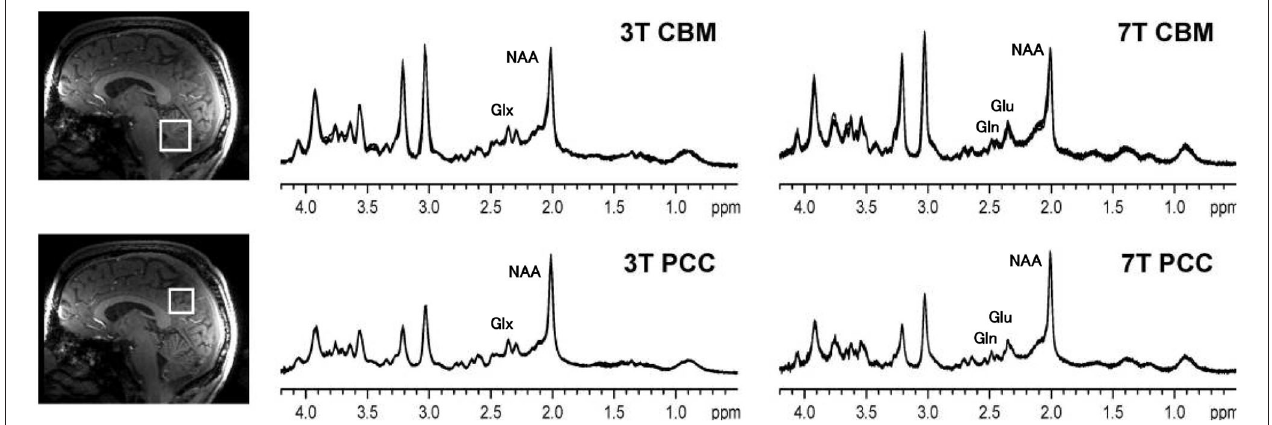
FIGURE 3 | 1 H MRS spectra from the cerebellar vermis (CBM) and posterior cingulate cortex (PCC) of a healthy control sequenced at 3 and at 7T. Compared to 3, at 7T the spatial resolution is improved and there is a better signal to noise ratio. At 3T the resonances of glutamate and glutamine overlap, and therefore Glx is reported, but glutamate and glutamine contribute to both of the peaks near 2.35 ppm. At 7T, the glutamate and glutamate resonances are cleanly separated. Thus, at 7T, the signal area of glutamate can be more accurately calculated. The figure is adapted from Figure 1 from Terpstra (35) with permission.